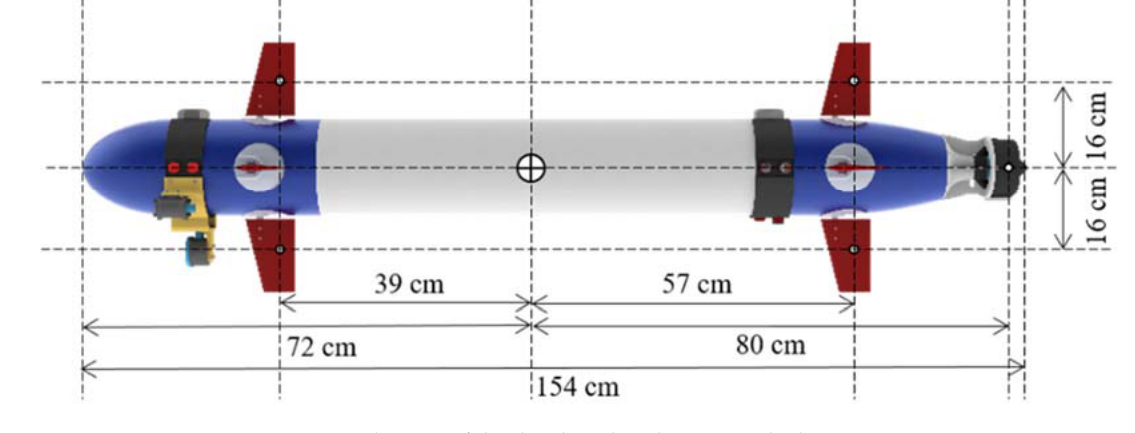
Figure 5. Side view of the developed underwater vehicle.